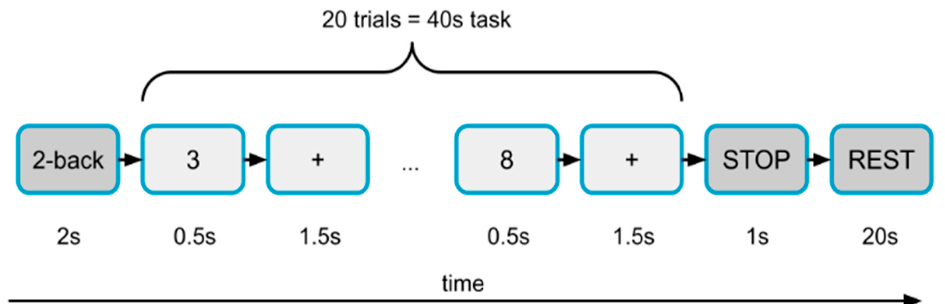
Figure 2. Layout of a set in the experiment. A single task consisted of a 2 s instruction indicating the type of task (0-, 2-, or 3-back), a 40 s task period that consisted of 20 trials, a 1 s stop period, and a 20 s rest period. Each participant completed nine sets of n-back tasks.